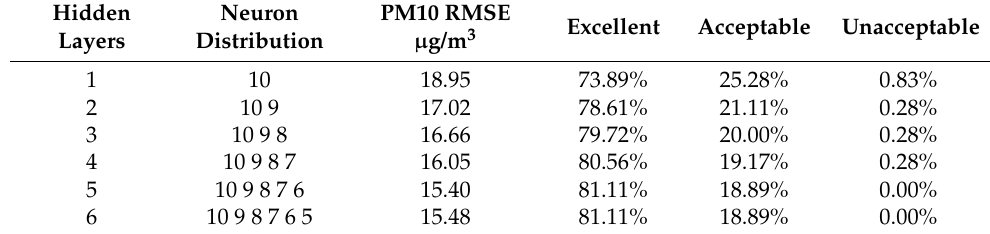
Table 4. PM10 prediction results with different hidden layers.